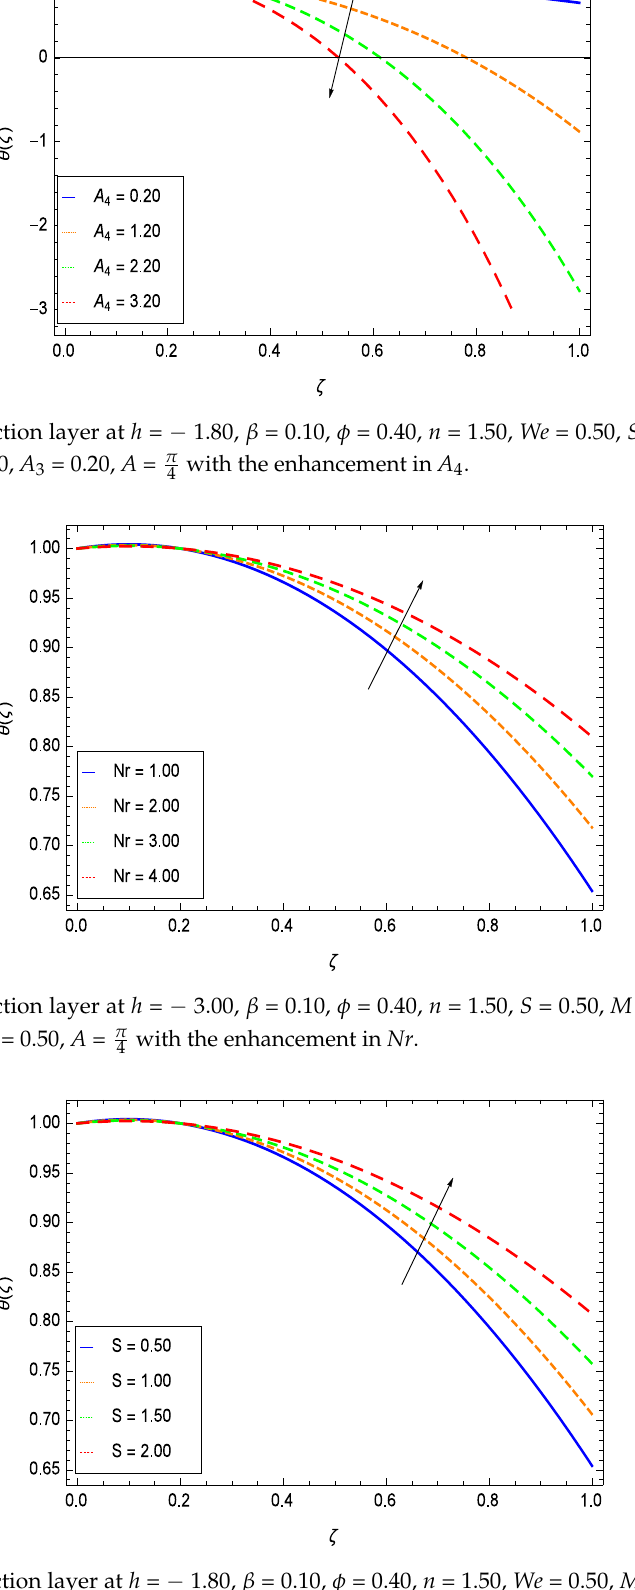
Figure 18. Conduction layer at h = − 1.80, β = 0.10, φ = 0.40, n = 1.50, We = 0.50, M = 0.50, Nr = 1.00, Pr = 10.00, A 3 = A 4 = 0.20, A = π with the enhancement in S 4